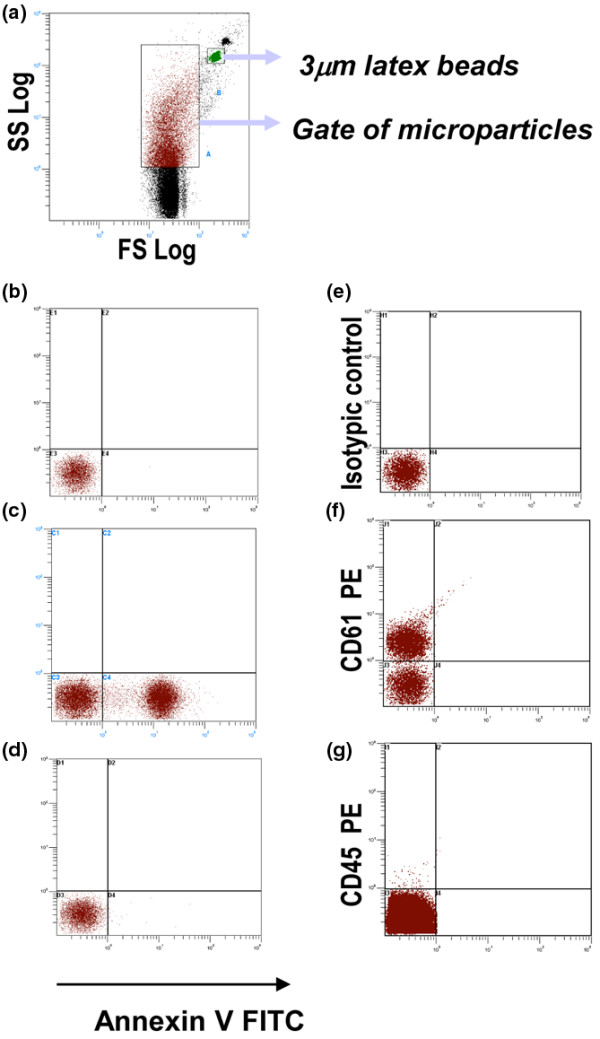
Representative flow cytometry density plots showing the gating protocol for microparticles. The gate of microparticles (MPs) was defined by use of Megamix containing fluorescent latex microbeads (0.5, 0.9 and 3 μm) (a) Quantitative estimation of MPs involved use of a fixed number of 3 μm microbeads, which were counted concomitantly with MP acquisition in the specific gate. (b to d) Gated MPs alone (b) without annexin V addition, (c) stained with annexin V FITC in a calcium-specific buffer, and (d) stained with annexin V in PBS (without calcium). (e) Isotype controls, (f) platelet MPs (CD61+), (g) leukocytes MPs (CD45+) using a single staining.